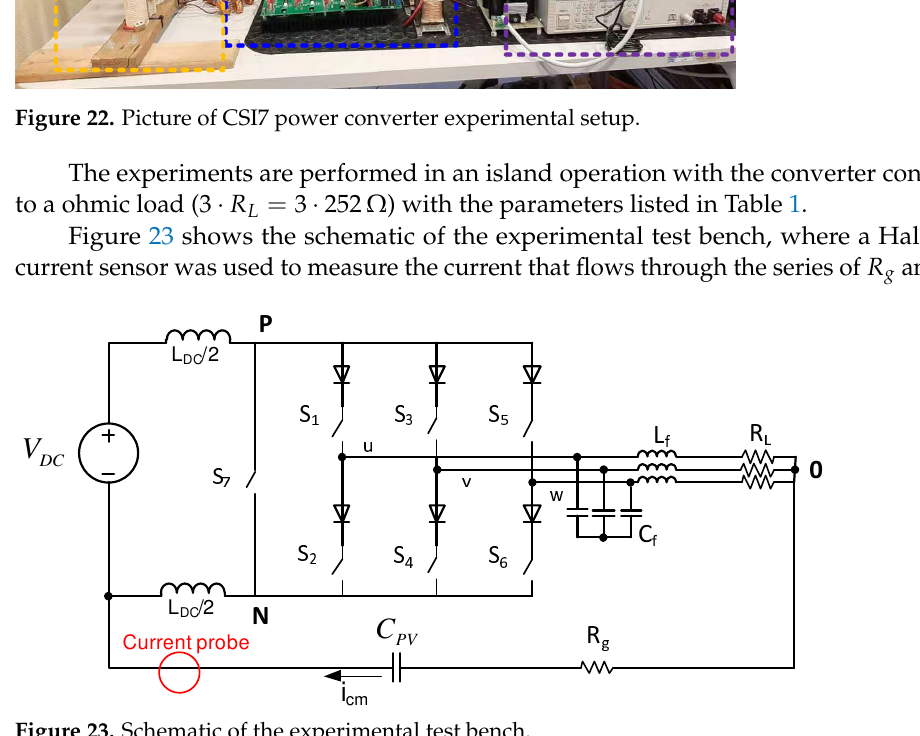
Figure 23. Schematic of the experimental test